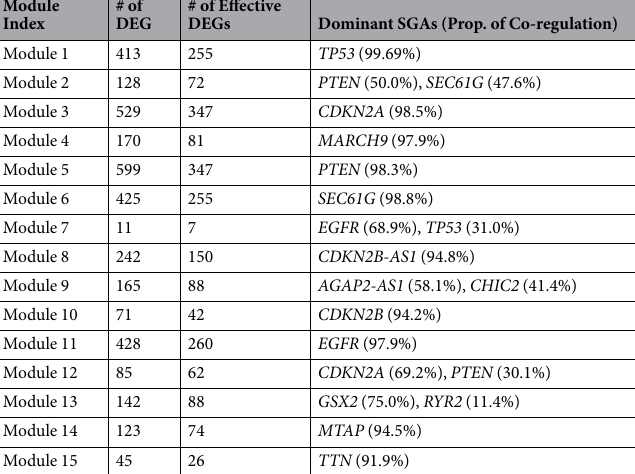
Table 2. The composition of DEG modules of GBM, including the number of DEGs, the number of effective DEGs, the dominant SGAs, and the proportion of co-regulations produced by each dominant